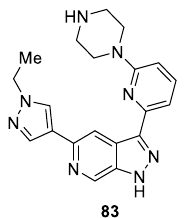
Figure 5. Chemical structure of 1 H -pyrazolo[3,4-c]pyridine (6-azaindazole) derivative 83 .